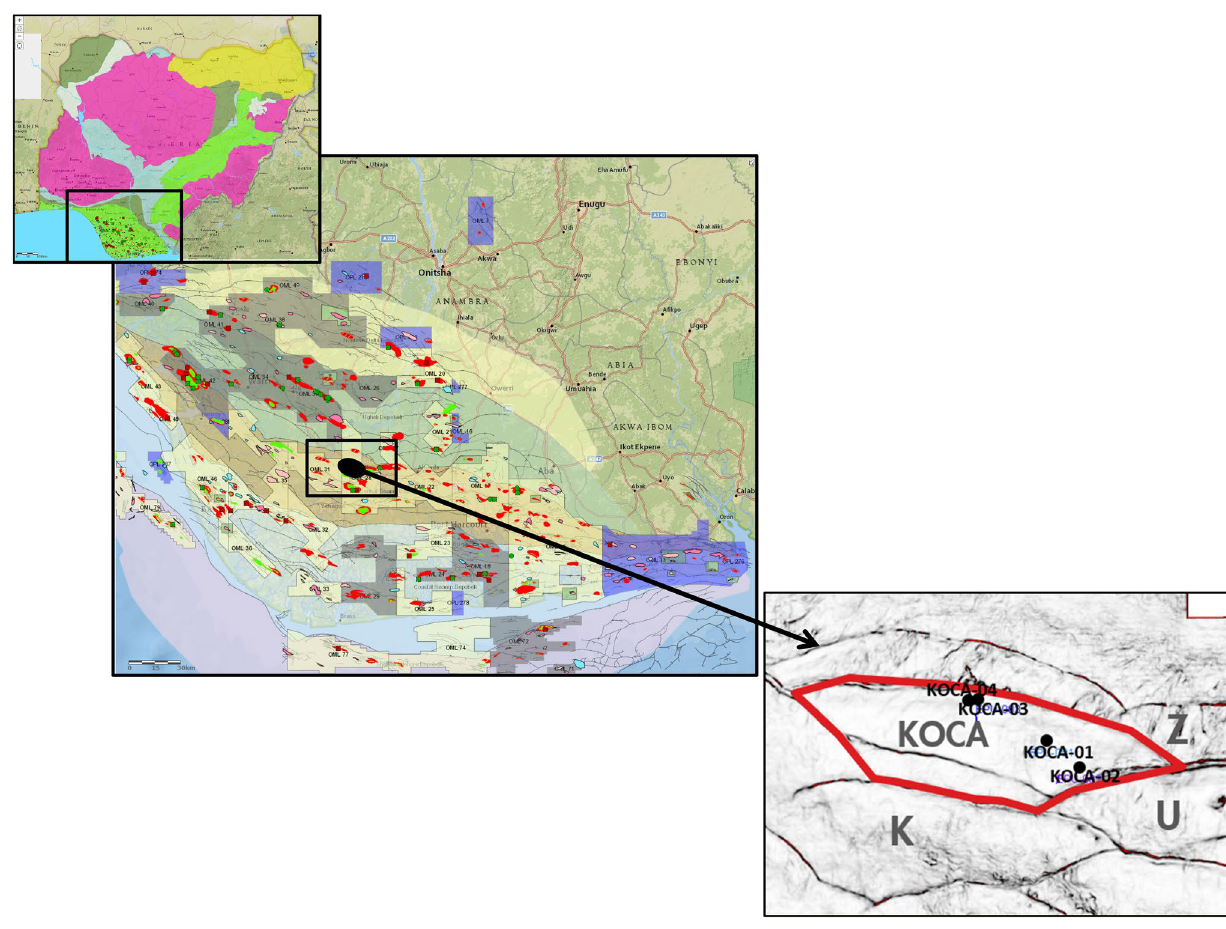
Fig. 4 Location of study area Koca field